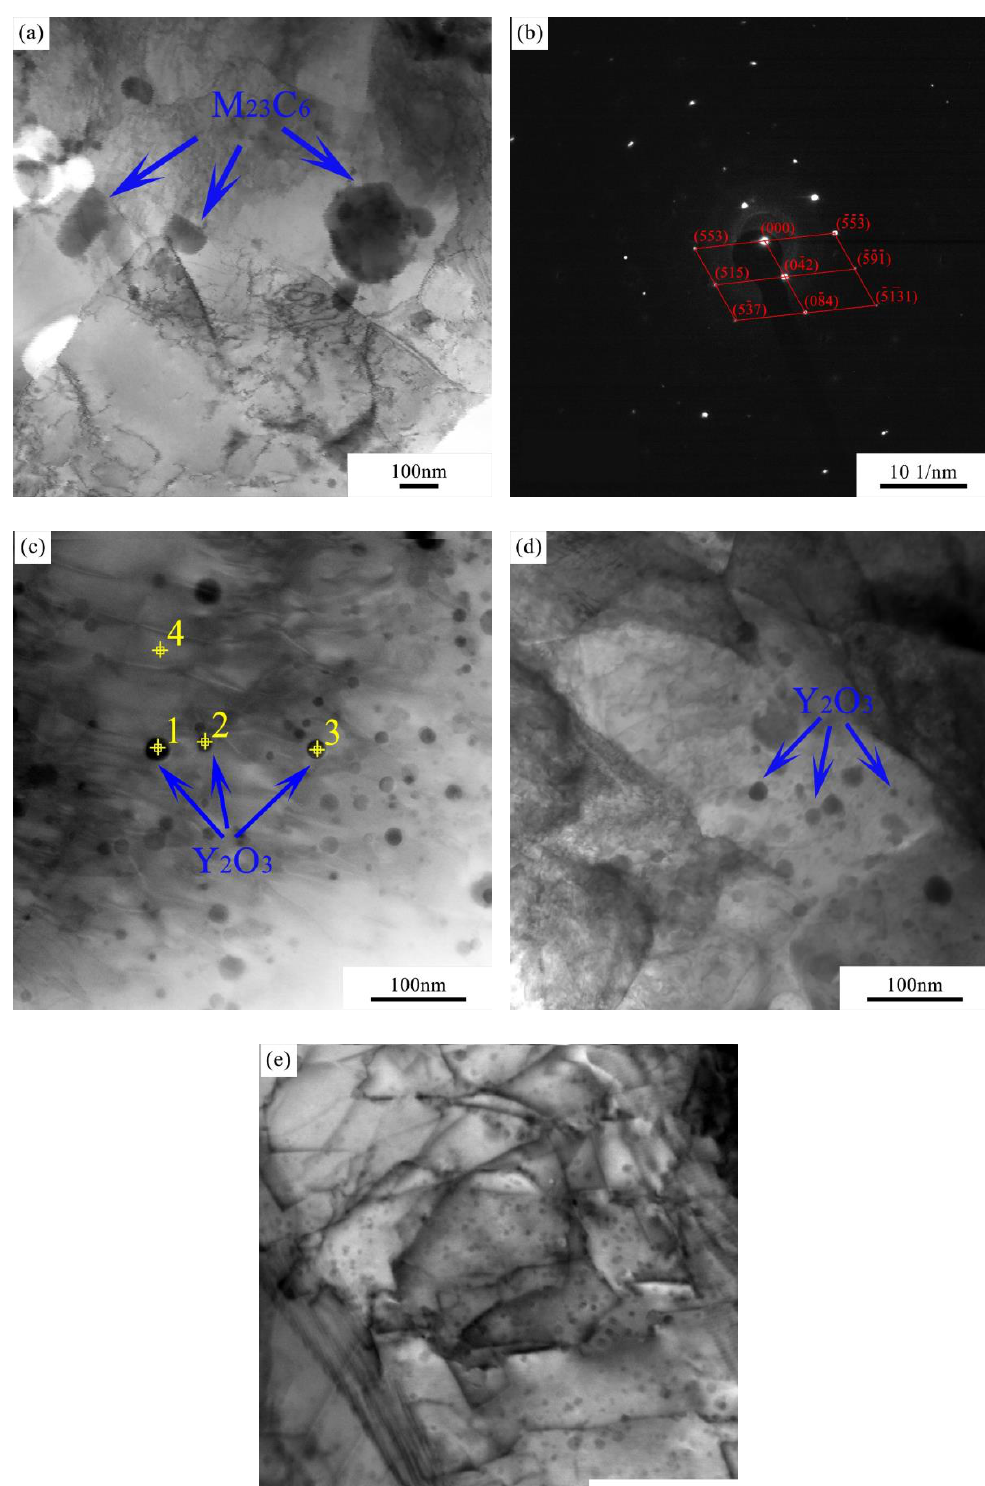
Figure 6. TEM images of the microstructural features: ( a ) M 23 C 6 carbides in the fusion zone, ( b ) di ff raction pattern of M 23 C 6 carbides, ( c ) Y 2 O 3 nanoparticles in the fusion zone, ( d ) Y 2 O 3 nanoparticles in the base material and ( e ) high-density